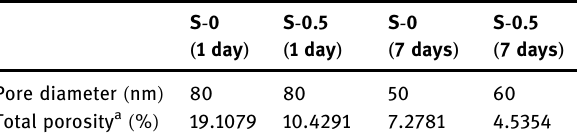
Table 4: Most probable pore size and porosity of cement